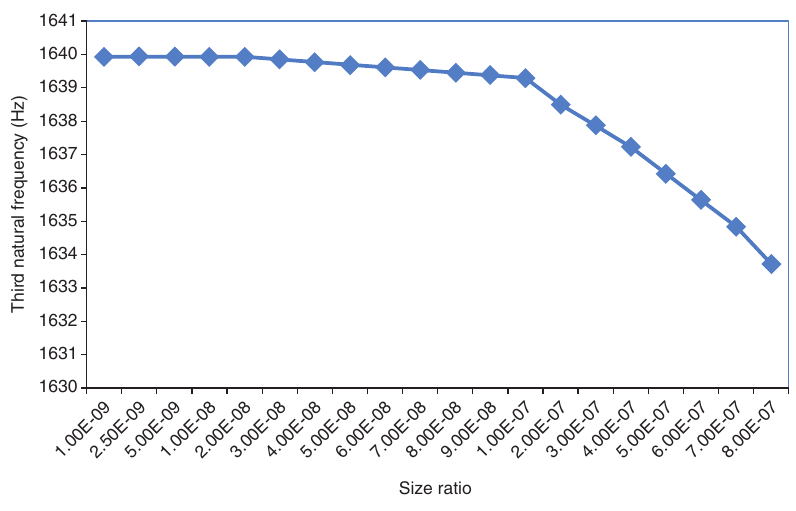
Figure 23: Variations of the third natural frequency of the simply supported beam with size ratio.